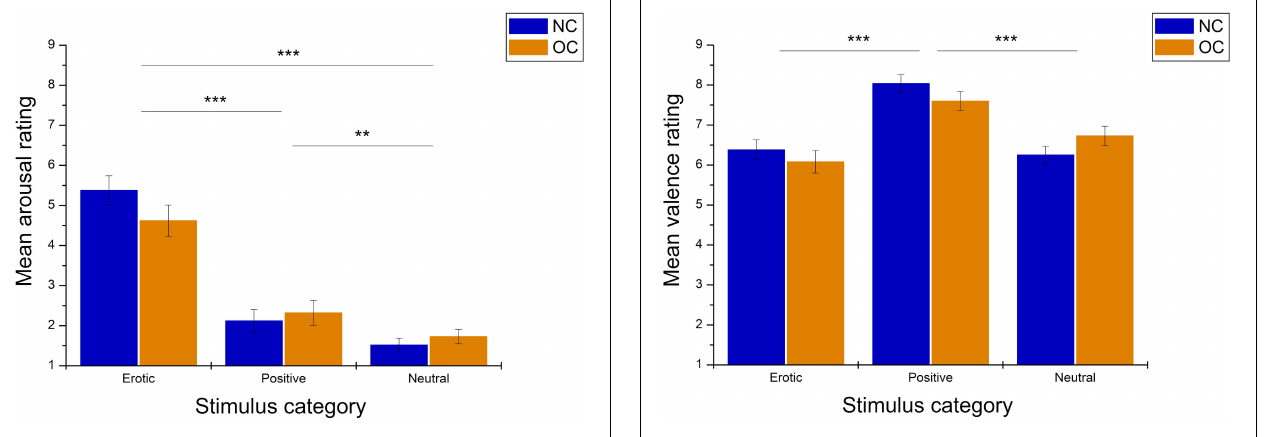
( Table 2 ): F ( 1 . 39 , 44 . 53 ) = 2.85, p = 0.086, η 2 ( Table 3 ): F ( 1 . 52 , 48 . 68 ) = 0.68, p = 0.473, η 2